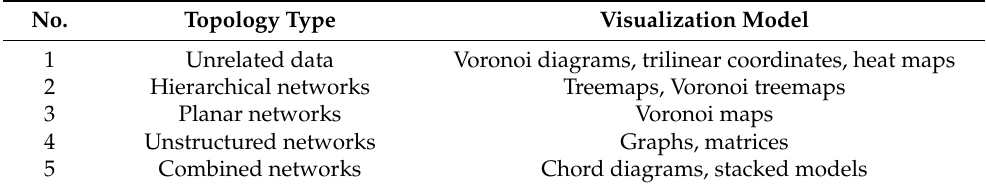
Table 2. Correspondence between a network topology and alternative visualization models. No. Topology Type Visualization Model Unrelated data Voronoi diagrams, trilinear coordinates, heat